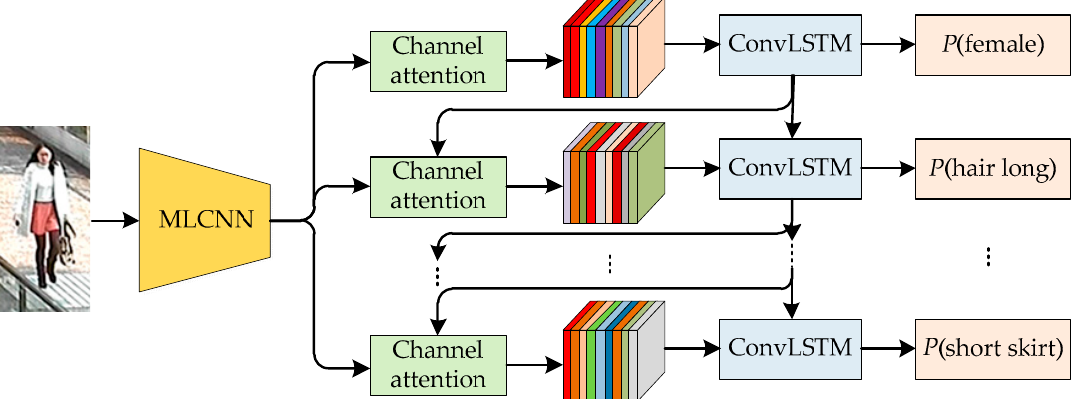
Figure 1. The architecture of proposed convolutional neural networks (CNN), channel attention (CAtt) and convolutional long short-term memory (ConvLSTM) model (CNN-CAtt-ConvLSTM) for pedestrian attribute recognition. MLCNN: multi-label classification CNN.